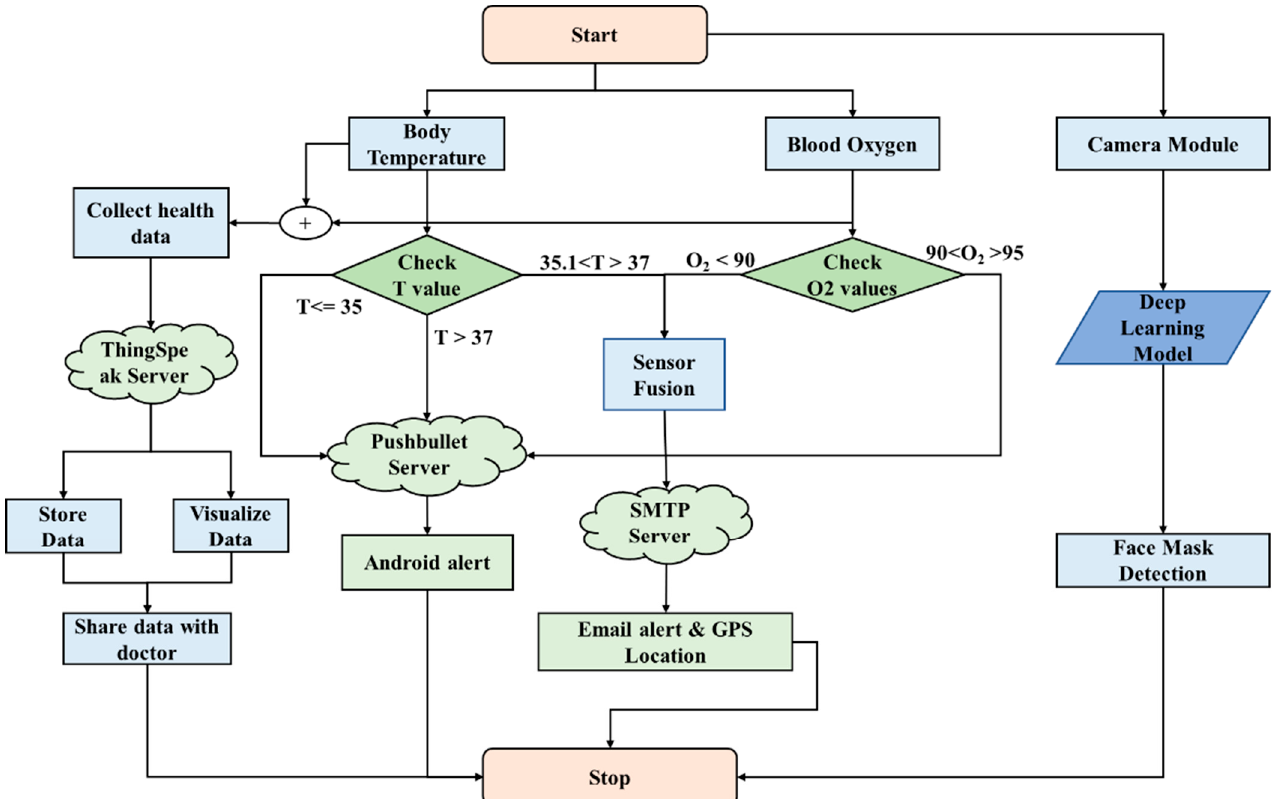
Figure 2. The data flow.